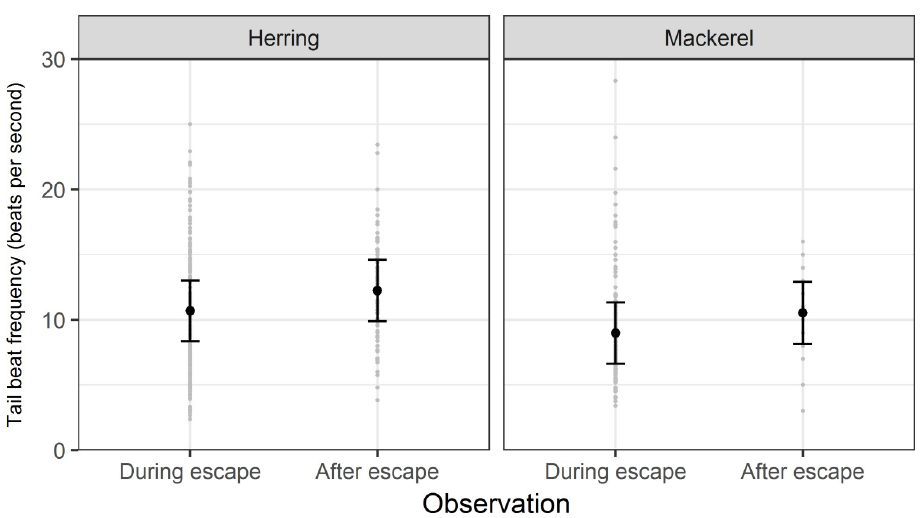
Fig 8. Tail beat frequency during and after escape. Model predicted mean (with 95% confidence intervals) tail beat frequency of mackerel and herring during and after slipping from purse seines.